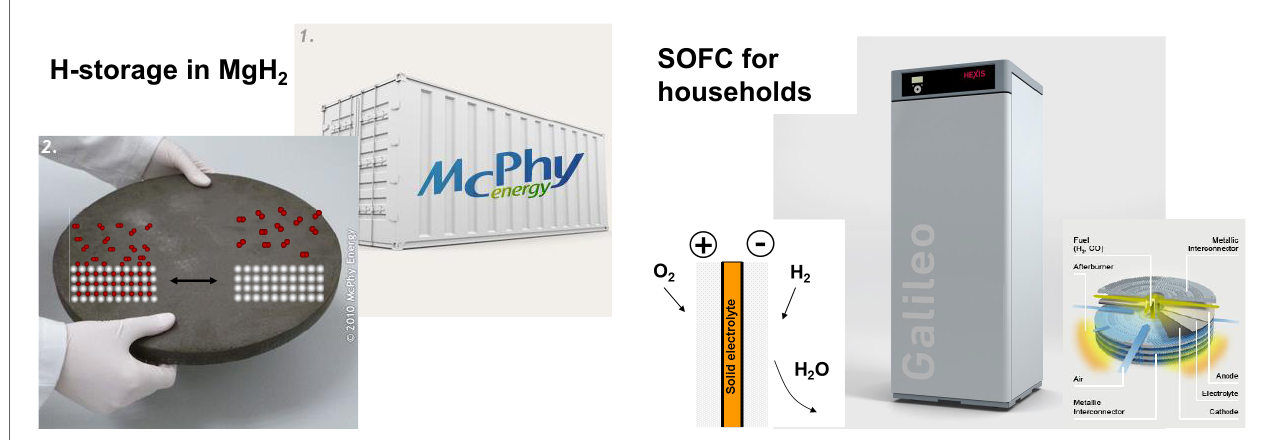
FiGUre 4 | two examples of a successful system integration of hydrogen technology . Left side: hydrogen storage in the high-temperature hydride MgH 2 (see footnote 4). Right side: SOFC units for households to produce heat and electricity from natural gas (see footnote 5).